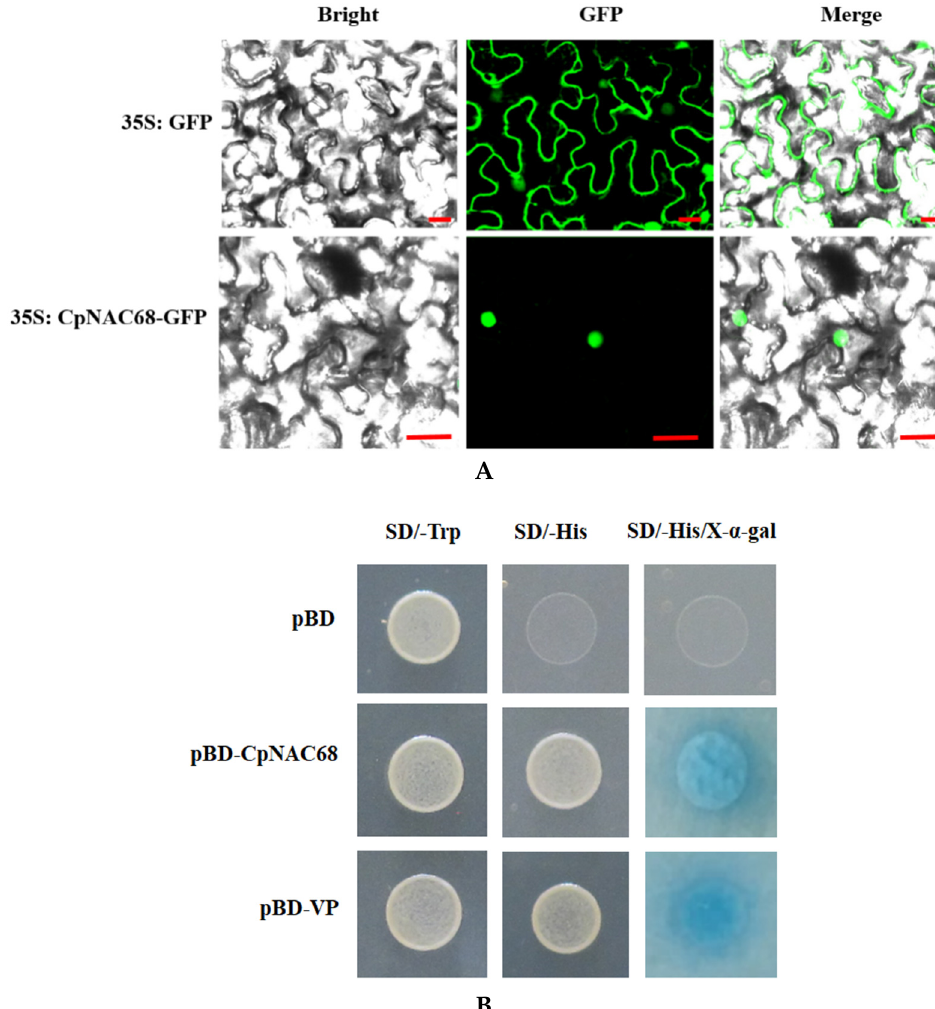
Figure 2. Subcellular localization and transcriptional activation activity of CpNAC68. ( A ) The control vector 35S:GFP and the recombinant vector 35S:CpNAC68-GFP were expressed in N. benthamiana leaf epidermal cells. Confocal images were captured 36 h after agro-infiltration and analyzed by laser scanning confocal microscope in bright, dark, and merged fields. Scale bar = 50 µ m. ( B ) Y2H Gold yeast transformed with pGBKT7 (pBD) (negative control), pGBKT7 − CpNAC68 (pBD- CpNAC68), and pGBKT7 − VP (pBD-VP) (positive control). Growth and the β –galactosidase activity